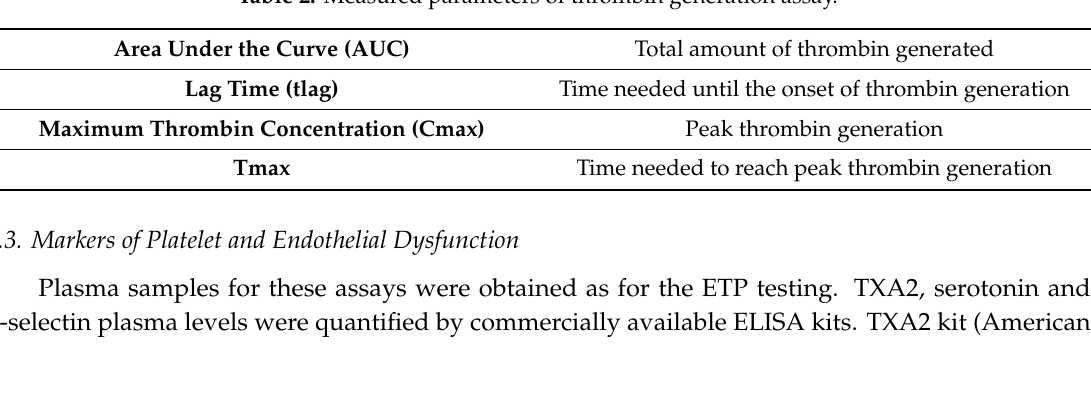
Table 2. Measured parameters of thrombin generation